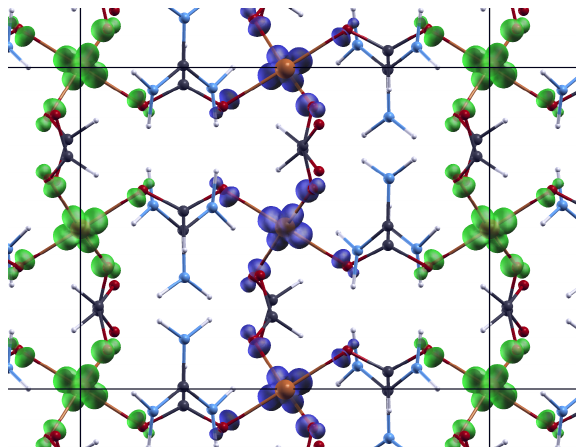
Figure 4. Spin polarization density (difference of electronic density of spin up and spin down) of ground state. Spin up polarization is shown with blue isosurfaces and spin down polarization is shown with green isosurfaces. Horizontal is crystallographic c direction and vertical is crystallo- graphic a + b direction.